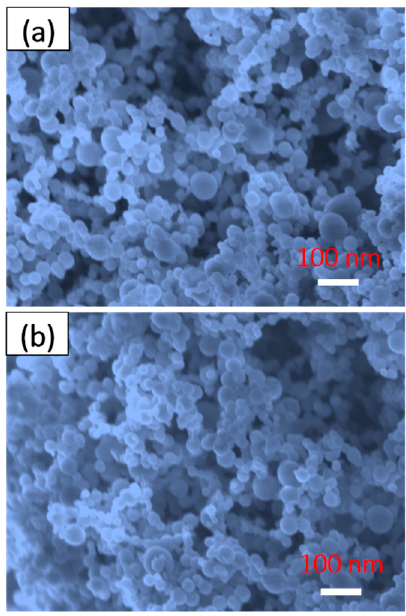
Figure 5. The typical FESEM images of the SAFFs before ( a ) and after ( b ) the exposure test for the six months.